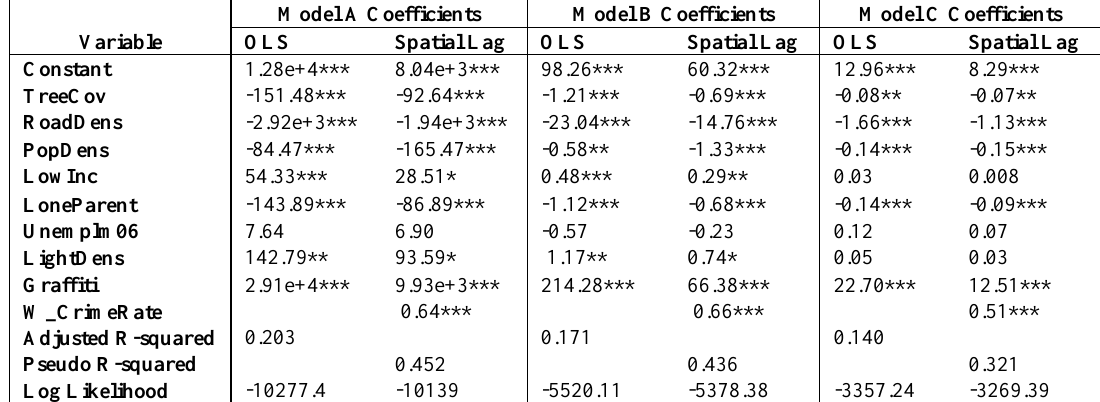
Table 3. Coefficients and significance levels of OLS and Spatial Lag regression models (Model A: property crime, Model B: theft, Model C: